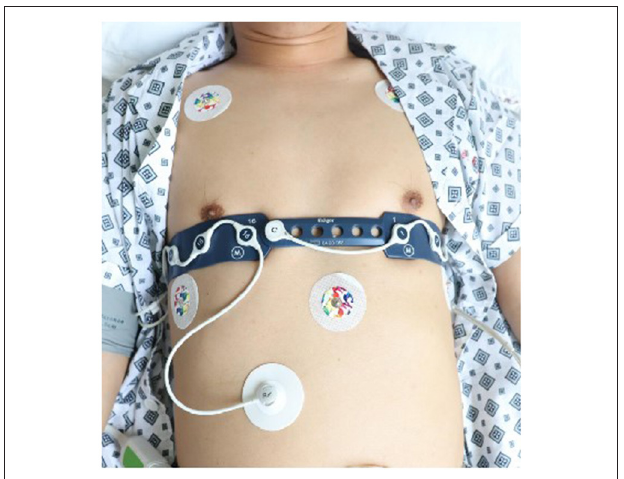
FIGURE 1 | Location of the EIT bind. EIT, electrical impedance tomography.